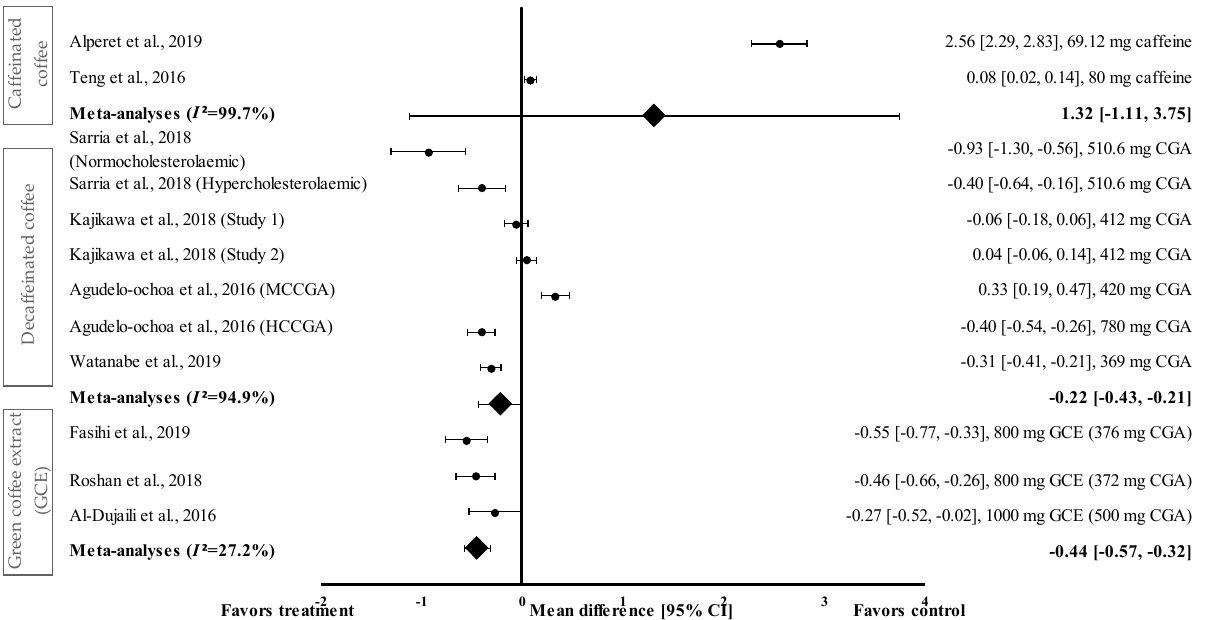
Figure 6. Forest plot showing the effect of caffeinated coffee, decaffeinated coffee, and GCE supplements on SBP, expressed as mean differences between the values obtained from the intervention and control groups. A negative effect size indicates that decaffeinated coffee and GCE supplements reduce SBP. Meanwhile, a positive effect size indicates that caffeinated and decaffeinated coffee increase SBP. Horizontal lines represent 95% CIs. Diamonds ( I 2 < 50%) represent the pooled effect size from fixed effects analysis. I 2 >50% represents the pooled effect size from random effects analysis. CGA: chlorogenic acid, CI: confidence interval, GCE: green coffee extract, HCCGA: high CGA content, MCCGA: medium CGA content, SBP: systolic blood pressure. The values ± 0.2, ± 0.5 and ± 0.8 represent small, medium, and large effect sizes [22–27,30,31,33].